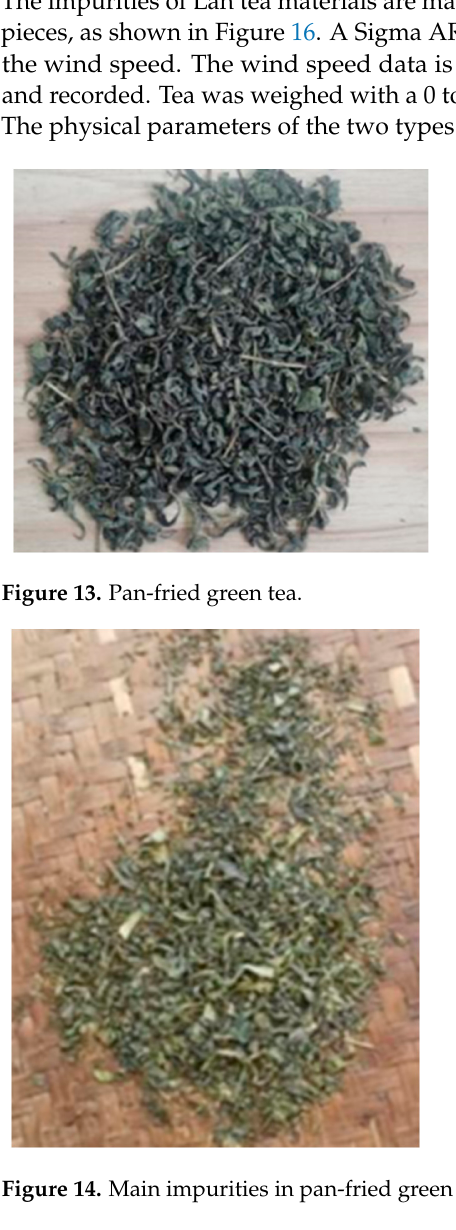
Figure 15. Materials of Lan tea.